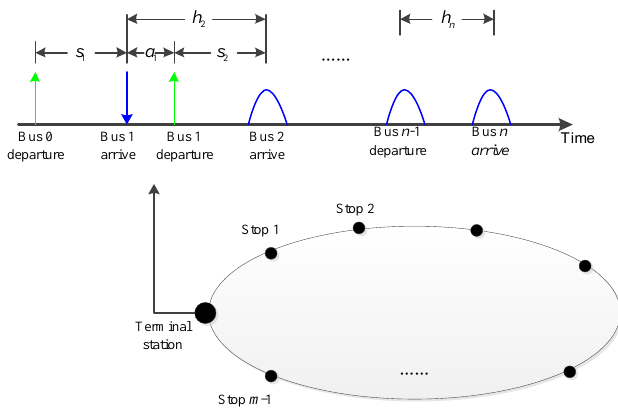
Figure 1. The transit route studied.